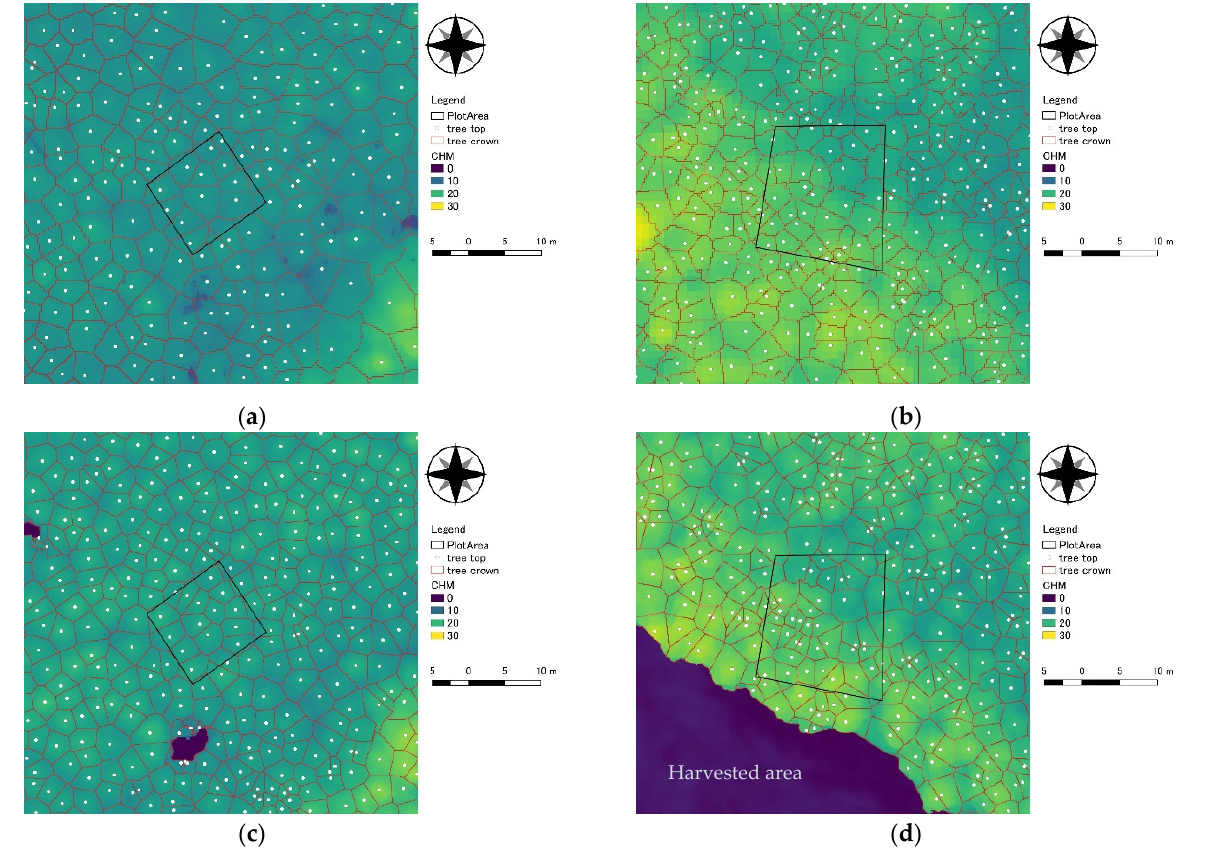
Figure 7. Detected treetops and segmented tree crowns overlaid with the ALS-CHM and UAV-SfM- CHM images for the Kameyama forest ( a ) and the Owase forest ( b ). The black polygons were canopy gaps at the Kameyama site ( c ) and bare land at the Owase site ( d ). The trees grown initially in this bare land area were harvested before acquiring UAV data in 2018. Table 4. Evaluation of the number of trees based on the image-interpretation-based manual deline- ation method and the PyCrown technique-based automatic delineation method.